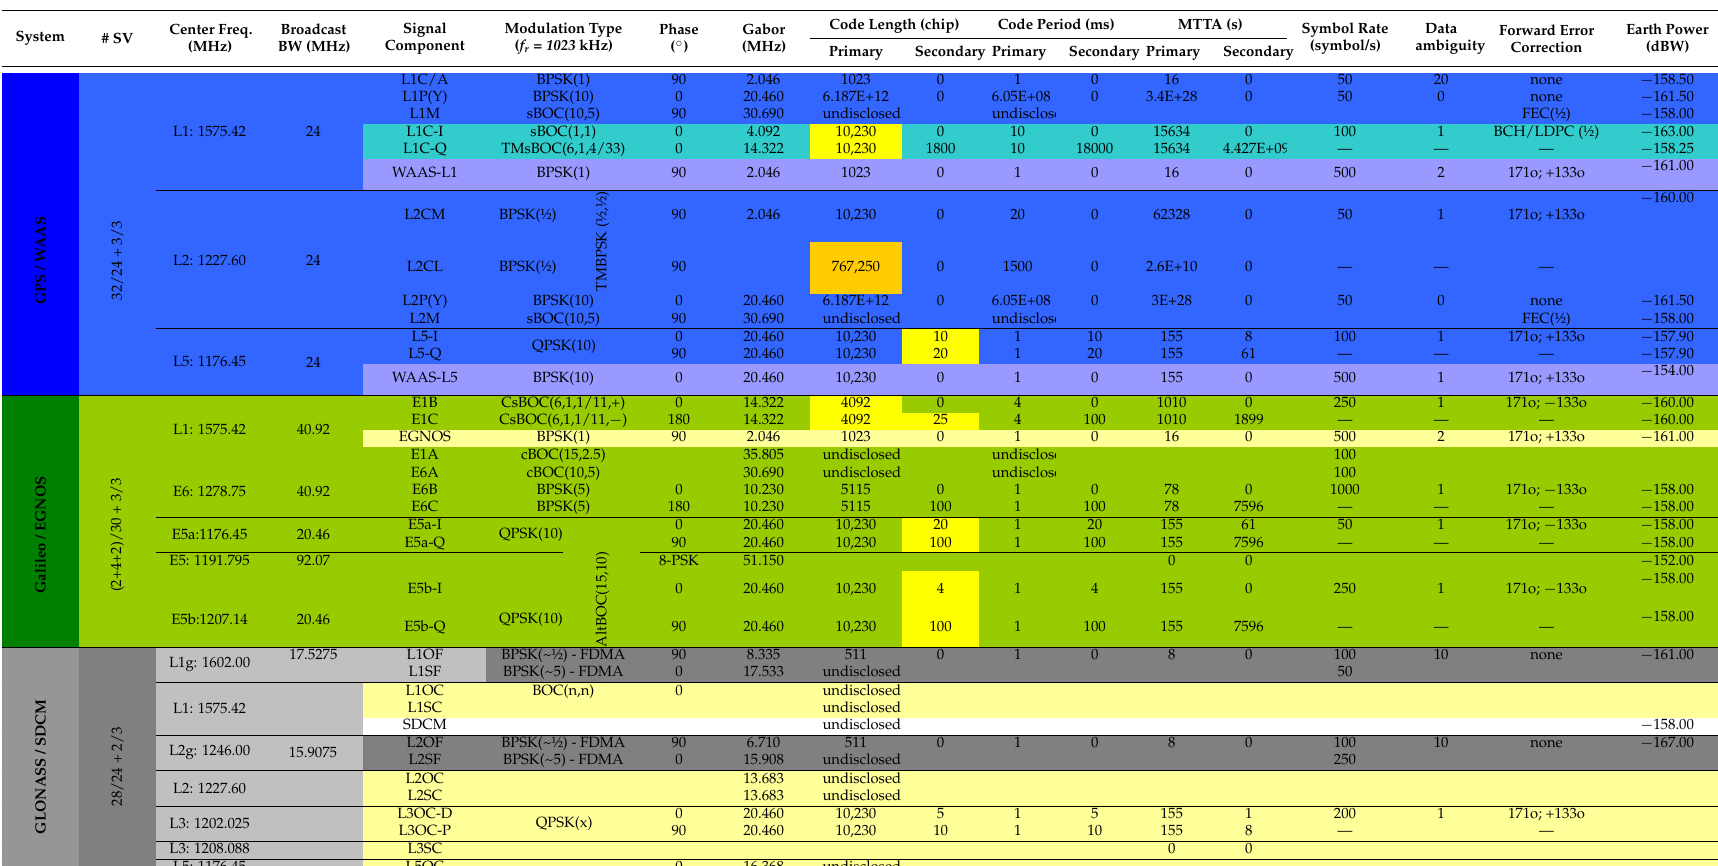
Table 1. GNSS Signals